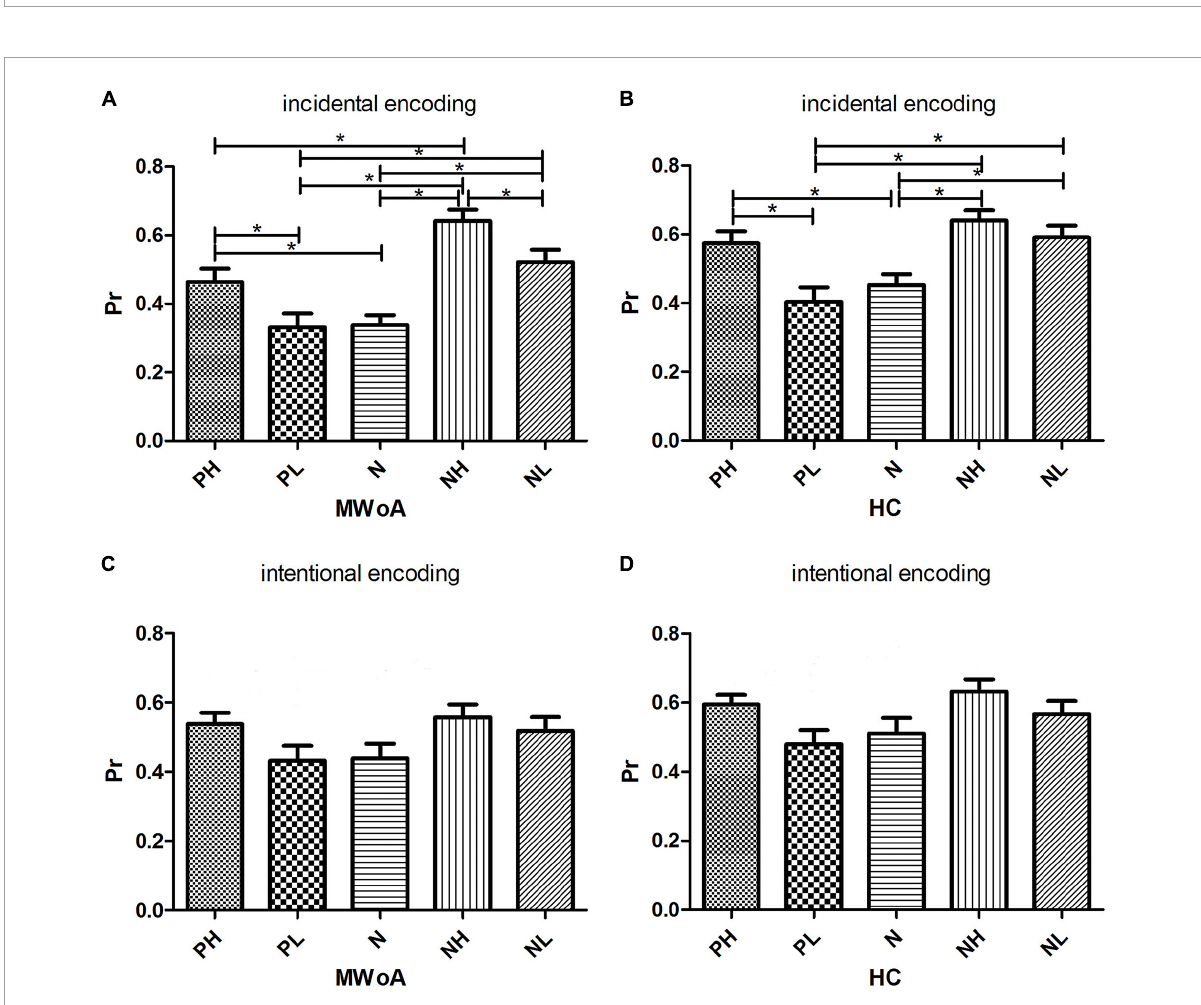
FIGURE3 Histograms of simple main effects of emotion on Pr value within the group. (A,B) The comparison of Pr between the 5 categories of stimuli under incidental encoding in MWoA patients and HCs, respectively. (C,D) The comparison of Pr between the 5 categories of stimuli under intentional encoding in MWoA patients and HCs, respectively. * p < 0.05. Bars represent means ± standard